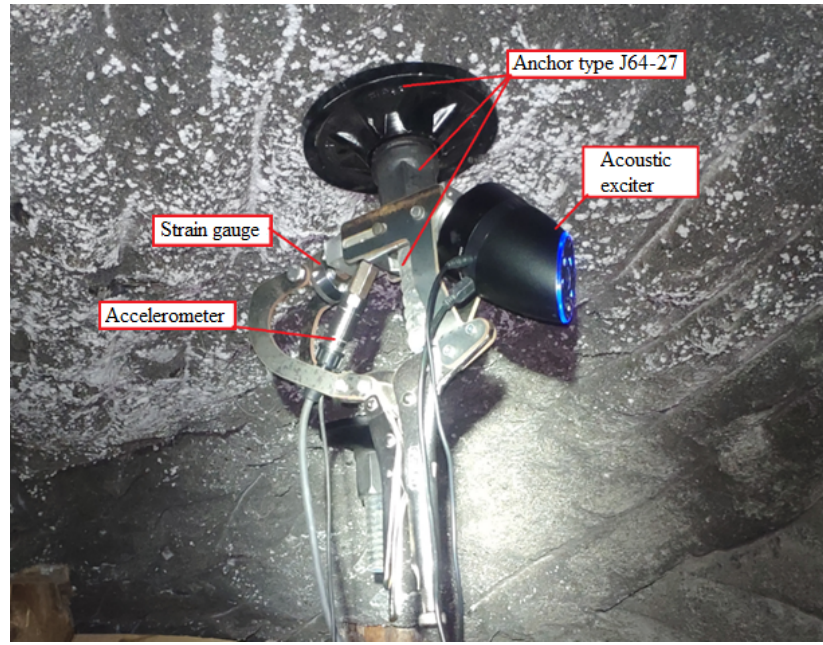
Figure 11. Testing fixture used during